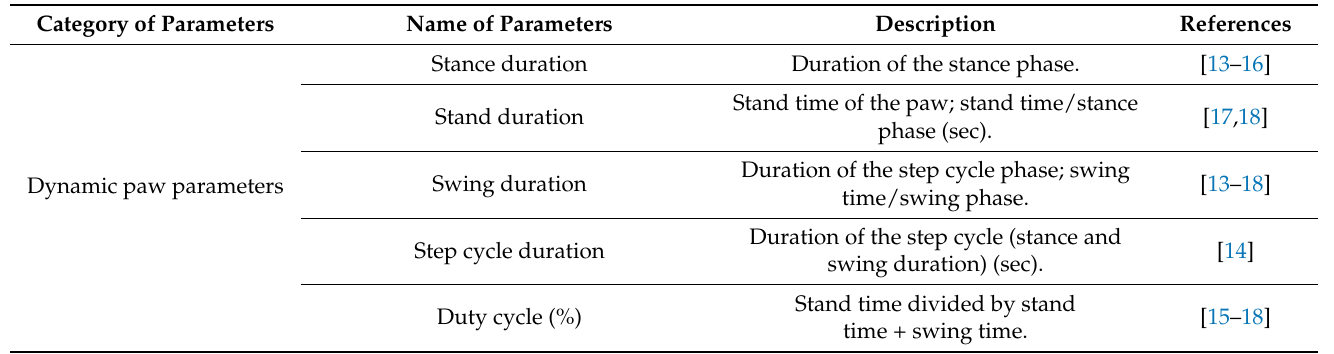
Table 1. The frequently used CW parameters and the references in which they were